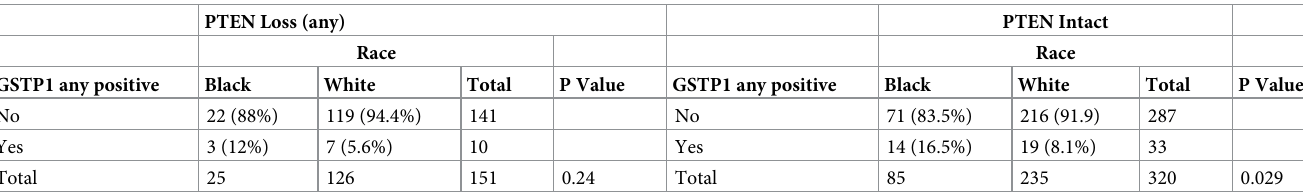
Table 8. GSTP1 protein staining by PTEN loss in Black and White patients. PTEN Loss